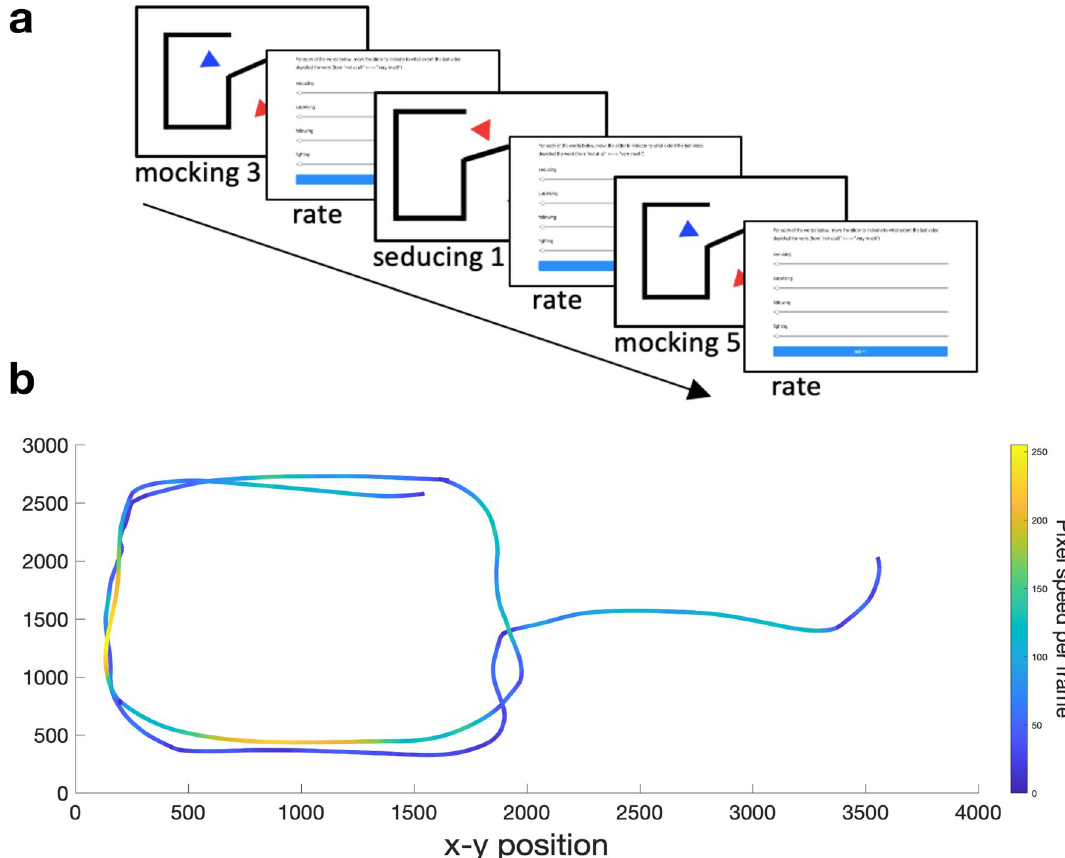
Figure 1. ( a ) Schematic depiction of three successive trials in the animations task . 37 participants watched videos from the database and rated the extent to which each video depicted mocking, seducing, surprising, following, or fighting. ( b ) Example trajectory of an animation stimulus. Each participant used a touchscreen device to create their own triangles animations. For each animation (both observed and generated by participants) we calculated jerk as the mean of the third order non-null derivative of the raw positional data across all frames; jerk similarity was calculated as the difference in mean jerk between an animation stimulus and the participant’s own animation of the same word ( jerk difference ). Depicted is an example of a following animation (one triangle’s